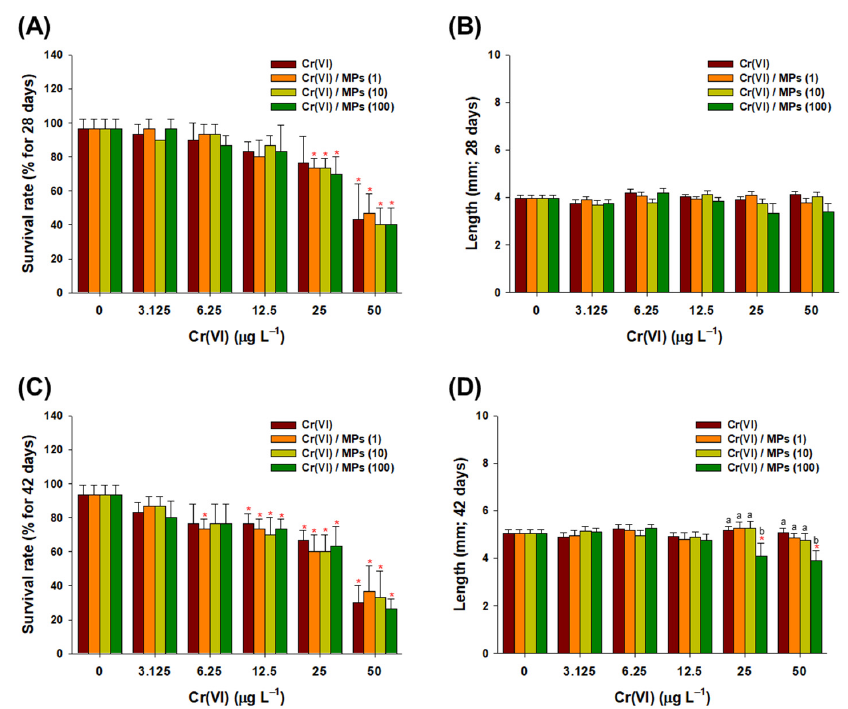
Figure 3. Toxicity test results for the amphipod Hyalella azteca . Measurement of the ( A ) survival rate and ( B ) growth (mm) of H. azteca in response to Cr(VI) (0–50 µ g L − 1 ) and the combination of Cr(VI) and 1 µ m MPs (1, 10, and 100 particles L − 1 ) at day 28. Measurement of the ( C ) survival rate and (S.D.). Letters indicate significant difference between the exposed groups on each concentration